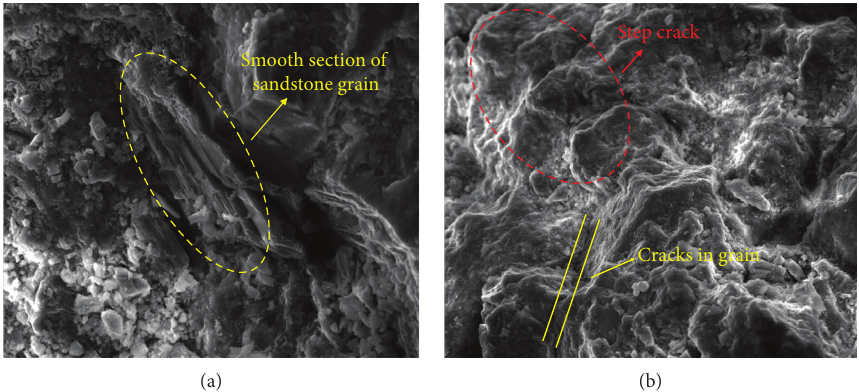
Figure 19: Electrical microscopy scan of the sample after 140s ultrasonic vibration duration. (a) Fracture place. (b) Crack